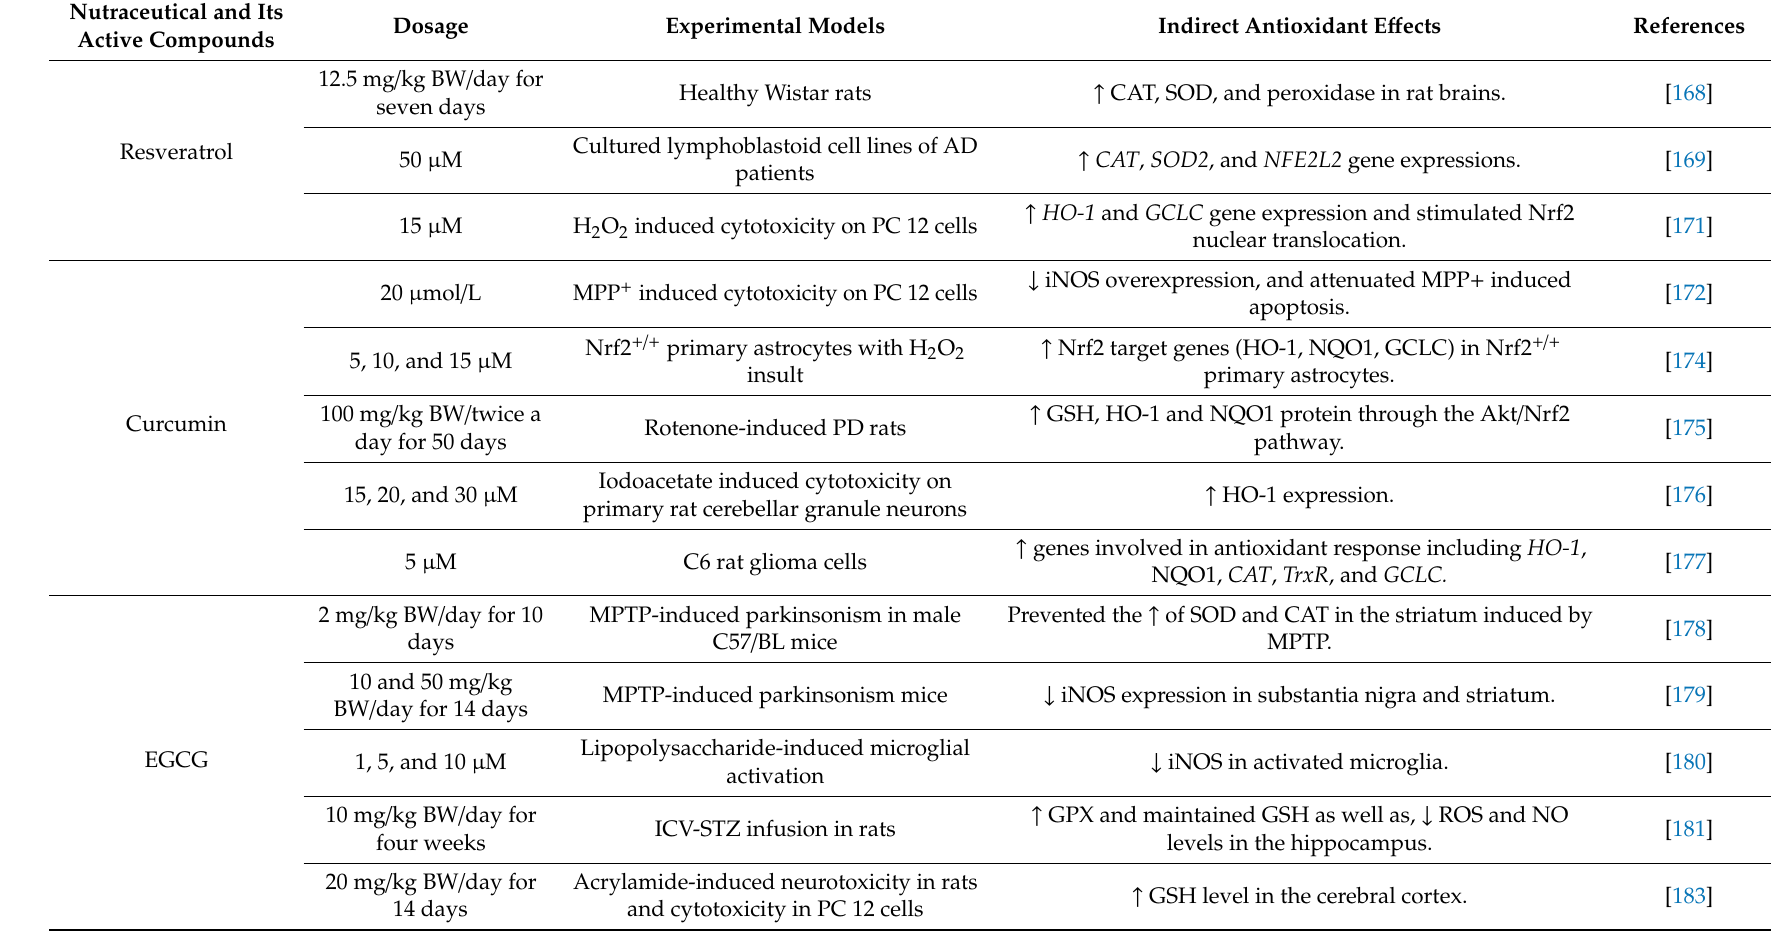
Table 3. Indirect antioxidation properties of